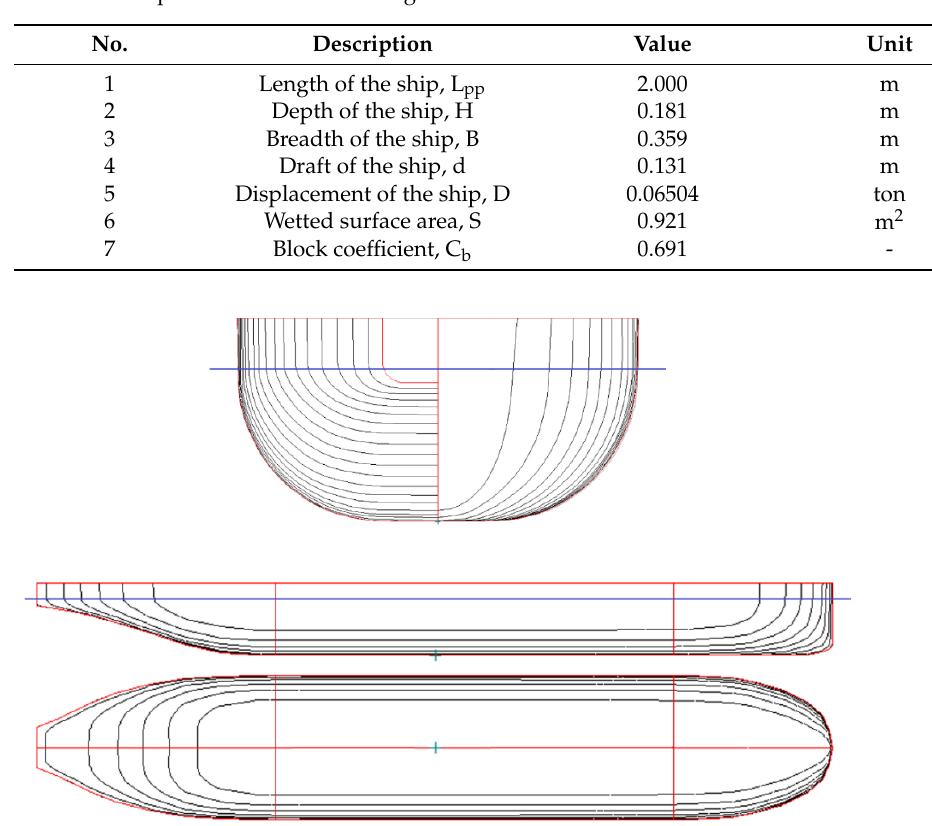
Figure 1. Original NBS developed by Professor Ikeda of OPU in Japan [2,3,17]. Table 1. Principal dimensions of the original NBS.